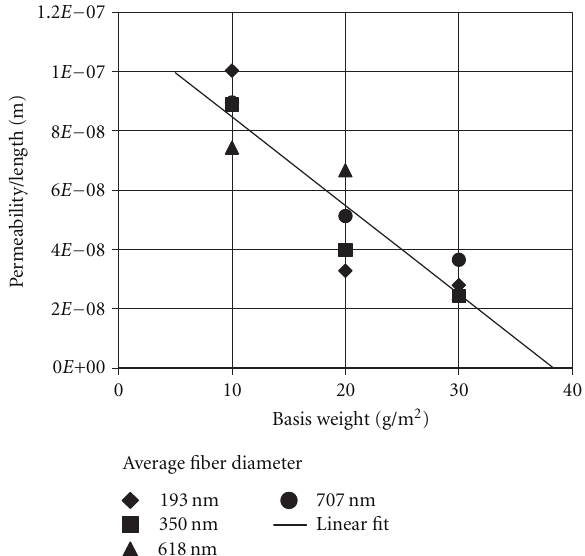
Figure 8: Linear fit of basis weight to the permeability/length. The linear fit is given in (2). The average diameters of the fibers are indicated by the data points for each basis weight.